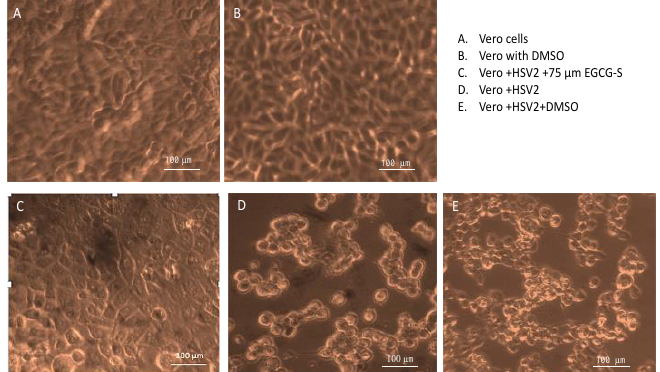
Figure 3. The morphological changes of Vero cells at different conditions. Vero cell monolayers were infected with EGCG-S treated or untreated HSV-2. Photographs were taken 48 h post-infection. ( A ) Uninfected and untreated Vero cell monolayers; ( B ) Vero cell monolayers treated with DMSO (1.5% concentration); ( C ) Vero cell monolayers infected with 75 µM EGCG-S treated HSV-2; ( D ) Vero cell monolayer infected with HSV-2; and ( E ) Vero cell monolayer treated with DMSO and infected with HSV-2.